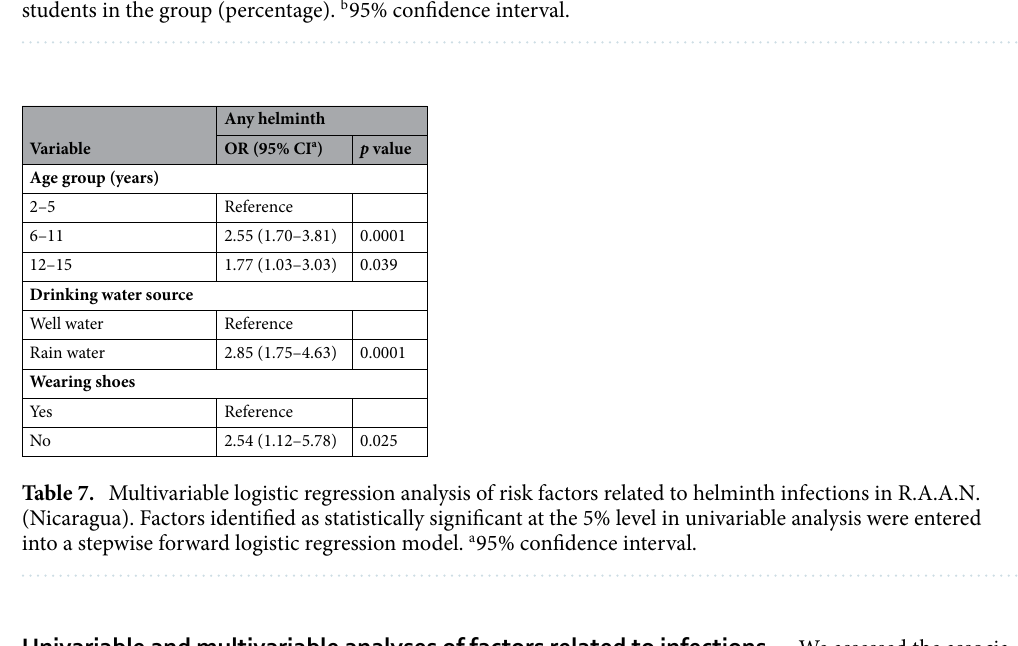
Table 6. Univariable analysis of variables related to any intestinal parasite infection, any protozoa and any helminth infection among children of R.A.A.N. (Nicaragua). * Significant association (5% level). a Positive students in the group (percentage). b 95% confidence interval.